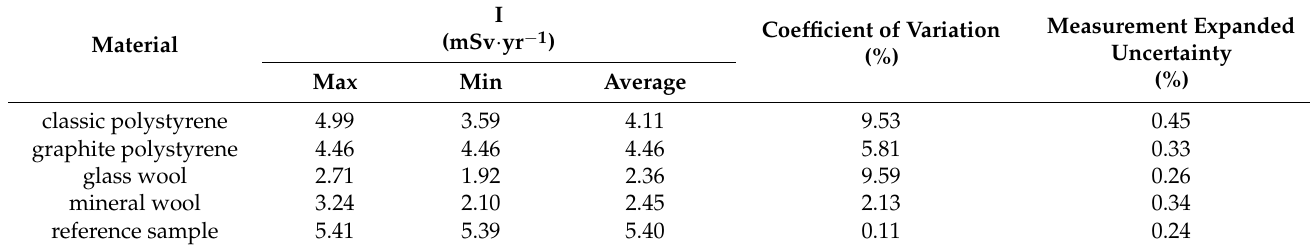
Table 4. Radioactivity concentration index measured for insulating materials.